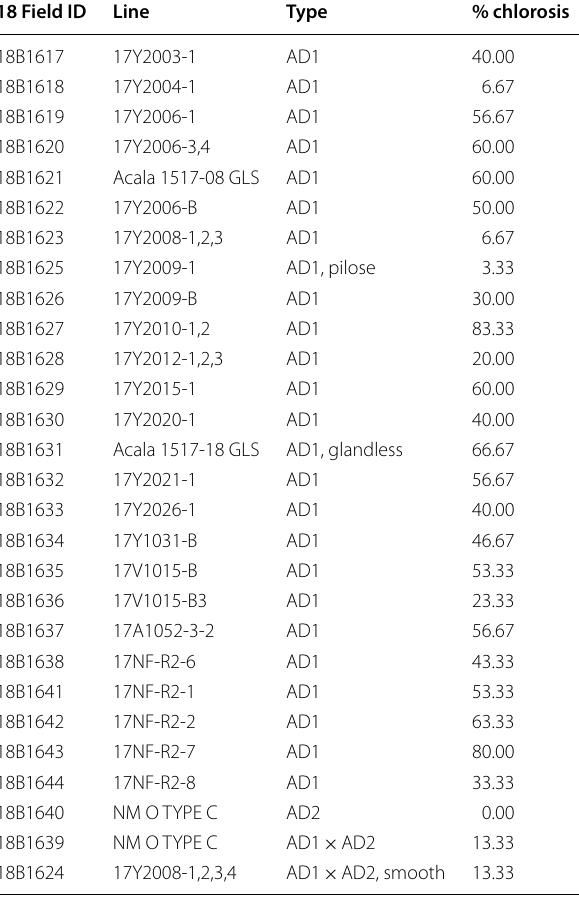
Table 3 Mean crop injury rating caused by herbicide trifloxysulfuron in test 16B with 25 Upland and 1 Pima cotton genotypes, and 2 AD1 AD2 segregants, Las Cruces, NM, ×